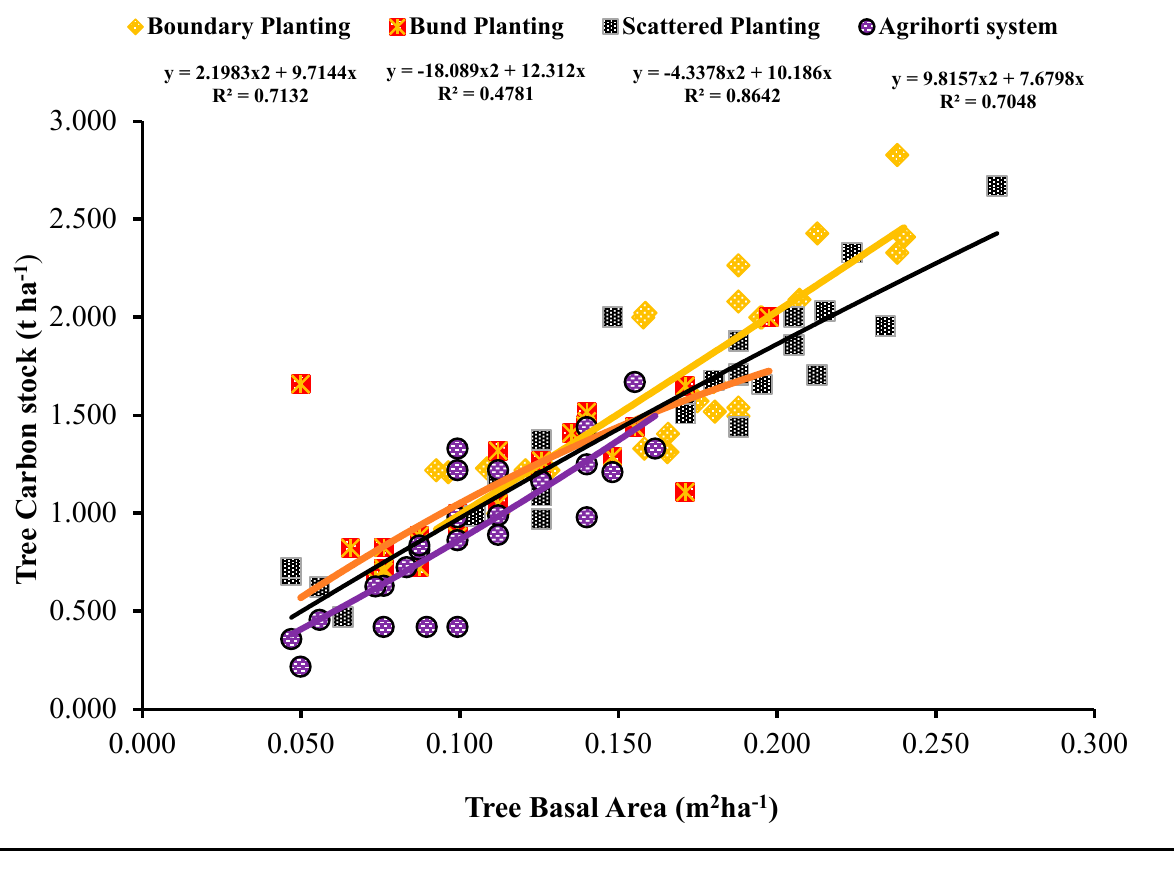
Figure 3. Relationship between tree biomass carbon stock (Mg ha − 1 ) and tree basal area (m 2 ha − 1 ) for agroforestry inventory plots in the study area. Table 4. Soil organic carbon and bulk density of different agroforestry systems in the semi-arid